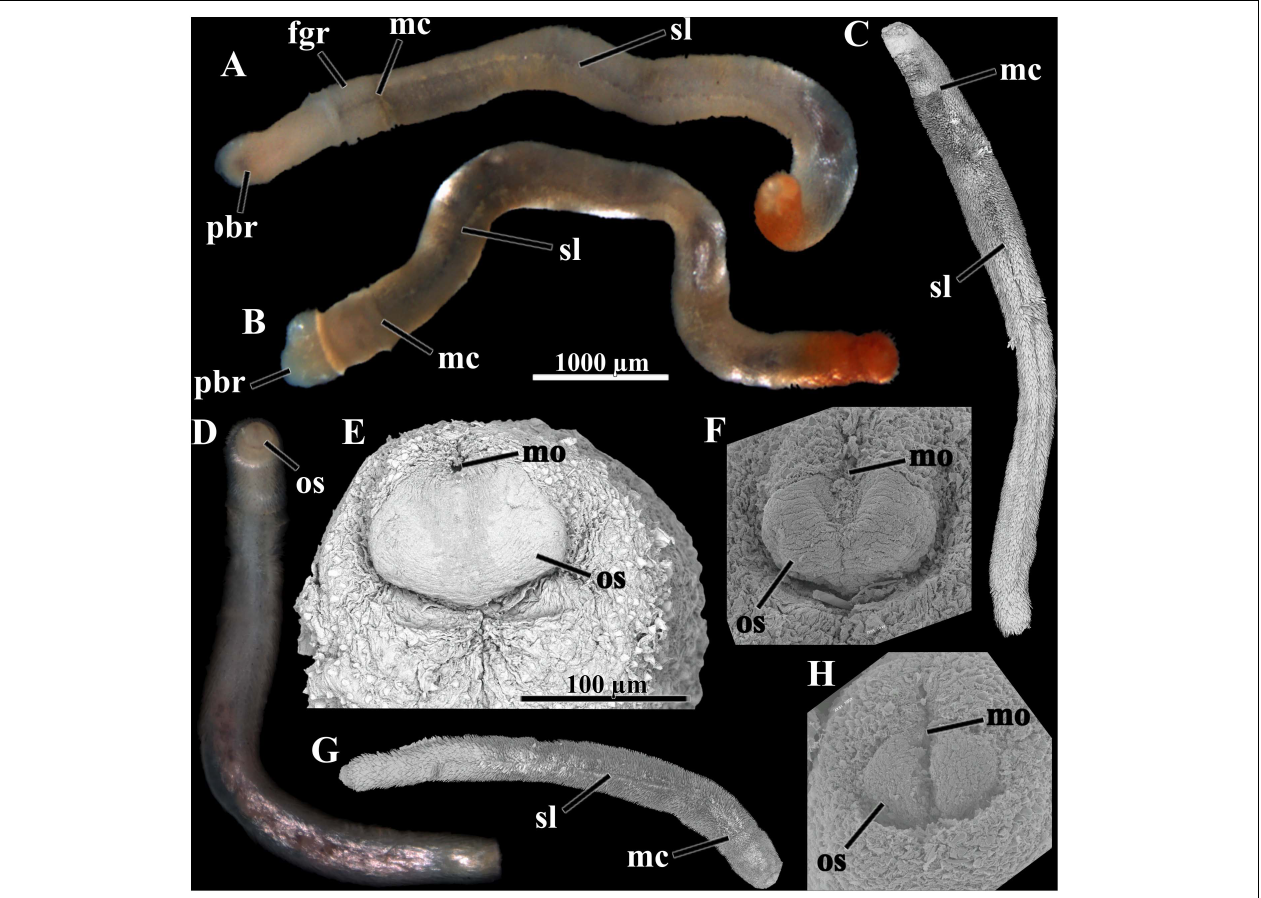
FIGURE 2 | Scutopus variabilis sp. nov. Photomicrographs under stereomicroscope [ (A) , (B), and (D) ] and SEM (C,E–H) ; (A–D) and (G) are in same scale, as are (E) , (F) and (H) . (E) , (F) , and (H) are a detail of the anterior end, showing the oral shield in different degrees of contraction; (E) is the oral shield of (D) , which is in the most relaxed state; in (F) it is in an intermediary state and in (H) it is strongly contracted appearing bipartite. The peribuccal region is protruded in (A) and (B) . The midventral suture line and the main collar are visible in (A–C) and G. fgr – foregut region, mc – main collar, mo – mouth, os – oral shield, pbr – peribuccal region, sl – midventral suture line. Voucher numbers: (A,B) – MNRJ 23639, (C) – ZUEC APL 306, (D) – ZUEC APL 280, (E) – ZUEC APL 280, (F) – ZUEC APL 314, (G) – ZUEC APL 312, (H) – ZUEC APL